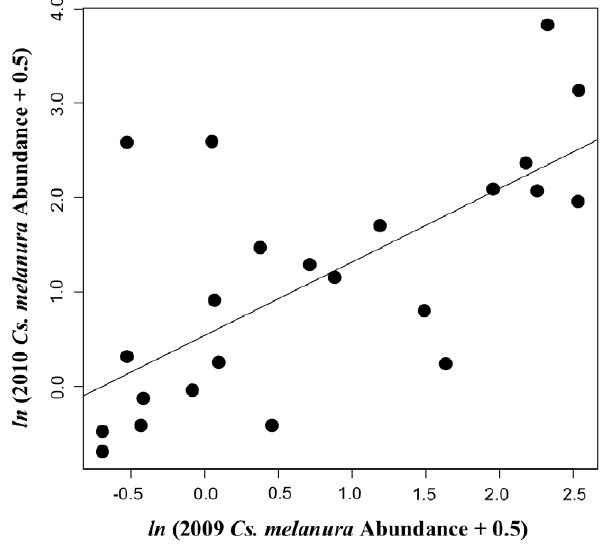
Figure 2. Association between annual Culisetamelanura abun- dances. Scatterplot showing the relationship between Cs. melanura abundance from April to October 2009 at 24 sentinel sites in Walton County, Florida with Cs. melanura abundance from the same sentinel sites and the same sampling period during 2010. Abundances from the two years are highly correlated (Spearman Rank Test, r S =0.63, p=0.001). The best-fit line from simple linear regression is overlaid.